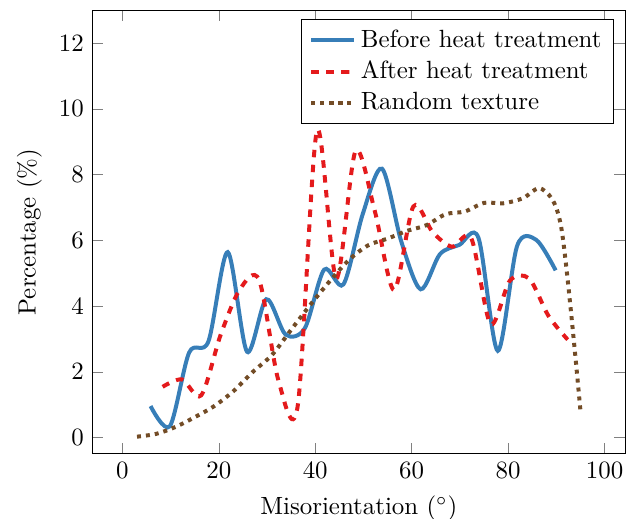
Figure 9. Histograms of the grain boundary misorientation before and after heat treatment. The bin size is 4 ◦